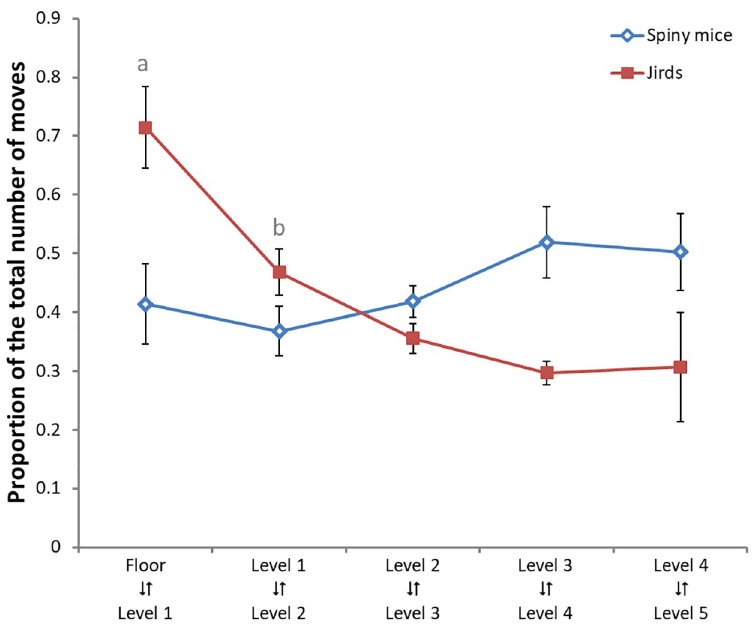
Fig 5. Transitions between the pyramid levels. Pairs of two adjacent pyramid levels are depicted along the abscissa, and the mean proportion ( ± SEM) of transitions between each pair of adjacent levels out of the total number of transitions during the 60 min test is depicted along the ordinate as proportion. As shown, the number of tansitions between two adjacent levels in jirds declined with their progress to the pyramid top; while in spiny mice it remained steady over all levels. A Fisher LSD post-hoc test revealed that jirds moved between the floor and the lowest pyramid level (level 1) significantly more than between all other levels (a), and the proportion of transitions between levels 1 and 2 were greater than between levels 3 and 4 (b). In spiny mice there was no significant difference in the proportion of transitions between the different levels and they indifferently moved between the pyramid levels.